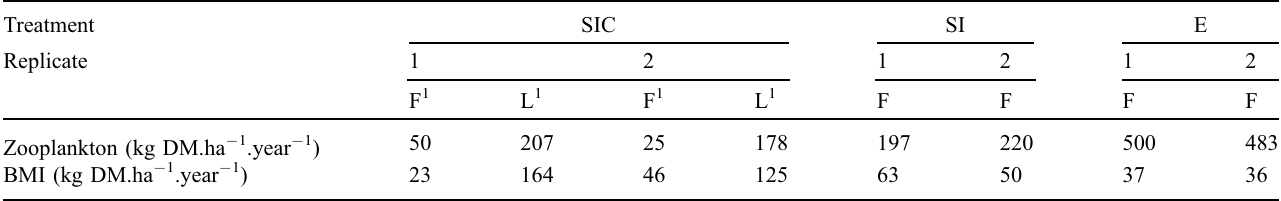
Table 4. Estimated annual production of zooplankton (zoopk) and benthic macro-invertebrates (BMI) in each fi shpond and lagoon of the Semi- intensive coupled (SIC), Semi-intensive (SI), and Extensive (E) treatments. Treatment SIC SI Replicate 1